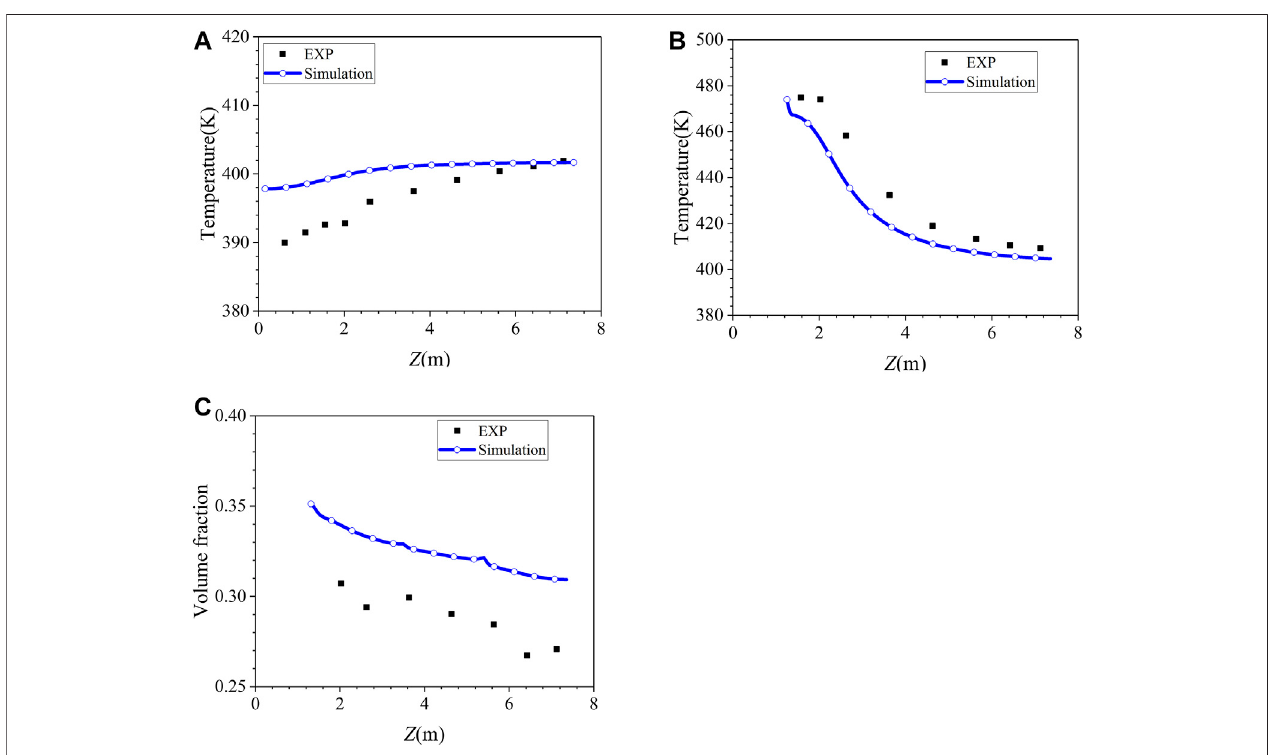
FIGURE 6 | Assessment results of original model. (A) Temperature vertical pro fi les along R2 axis (Phase A, t (cid:1) 4000 s). (B) Temperature vertical pro fi les along R0 axis (Phase B, t (cid:1) 9000 s). (C) Helium volume fraction along R4 axis (Phase B, t (cid:1) 9000 s).